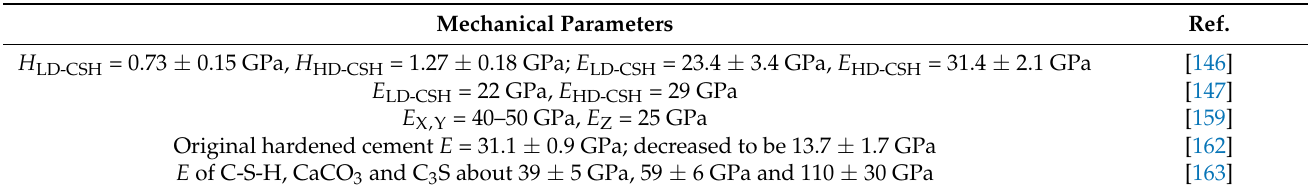
Table 7. Mechanical parameters of